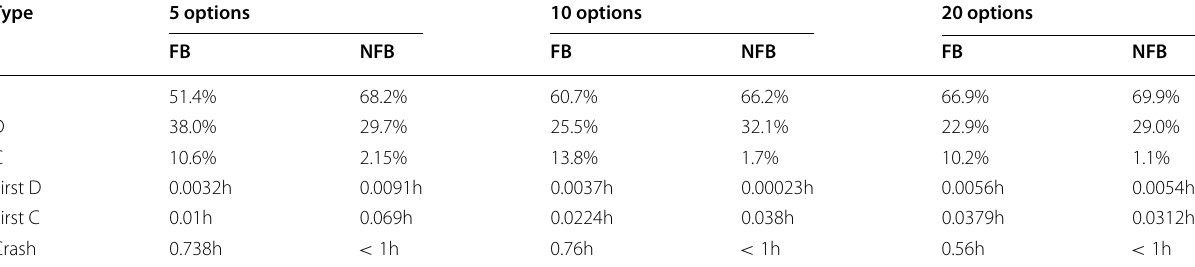
Table 7 Ratios and time about request type of VUL2